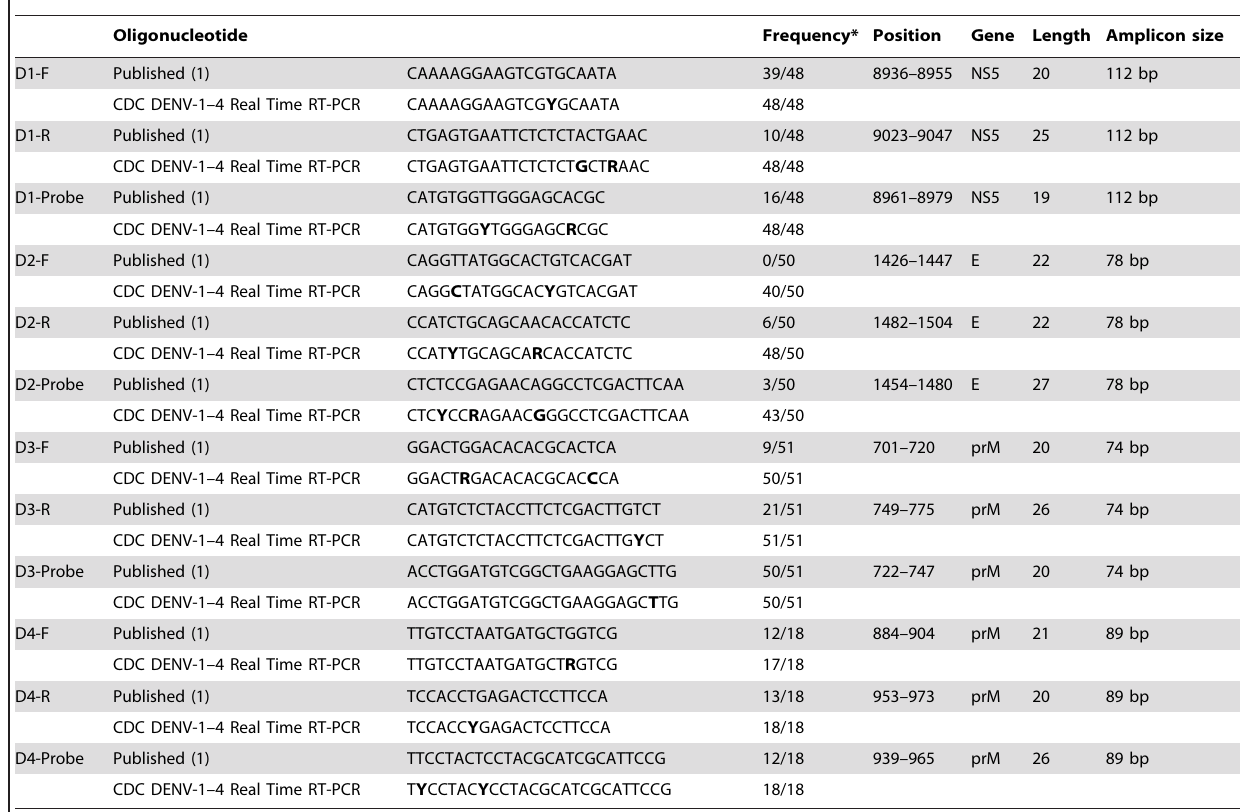
Table 1. Comparison of published and oligonucleotides used in CDC DENV-1–4 Real Time RT-PCR Assay.